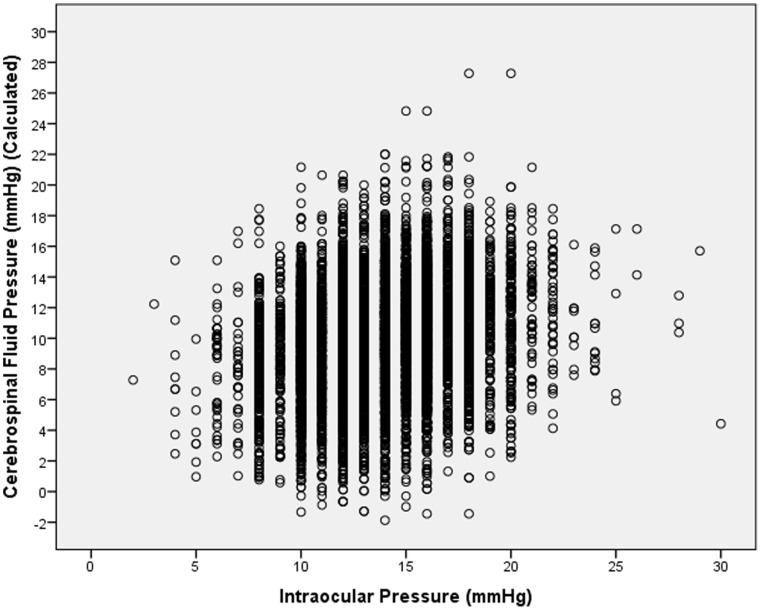
Scattergram showing the correlation between measured intraocular pressure and calculated cerebrospinal fluid pressure in the non-glaucomatous and non-highly myopic population of the Central India Eye and Medical Study.(P<0.001; correlation coefficient r: 0.22; equation of the regression line: Calculated Cerebrospinal Fluid Pressure [mmHg] = 0.25×Intraocular Pressure [mmHg]+6.64 mmHg).